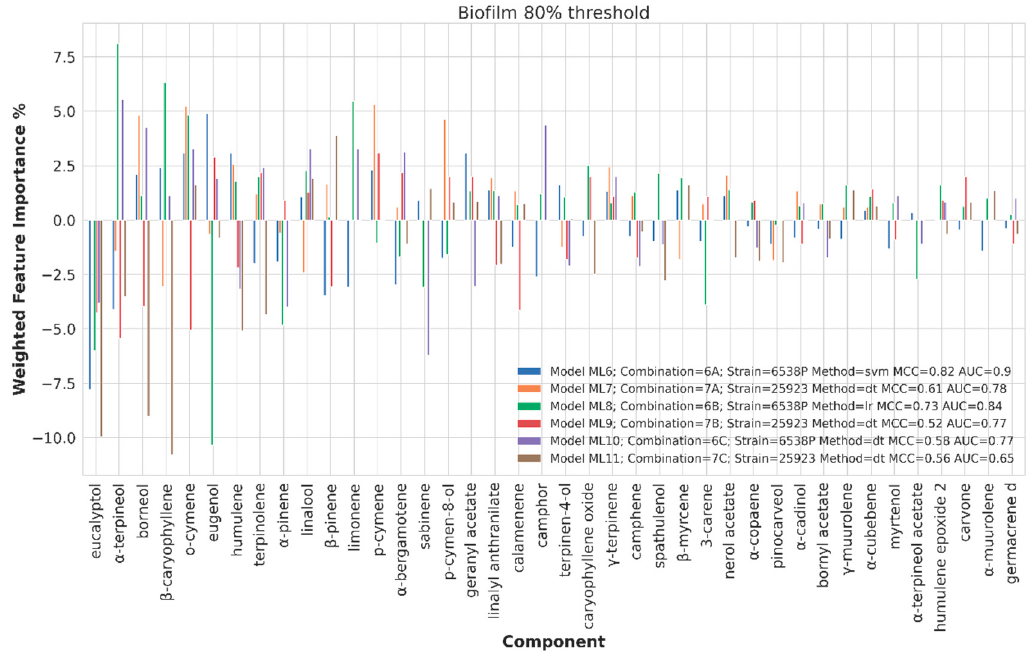
Figure 7. Weighted feature importance (WFI) plot for models obtained on the dataset binarized at 80% biofilm inhibition. Positive bars are associate with inhibition of biofilm production, whereas negative bars are associated with augmented biofilm production.